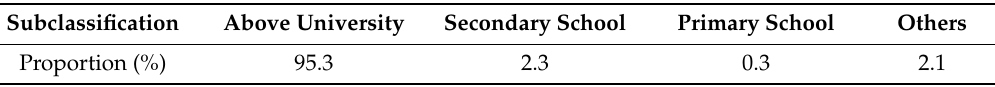
Table 7. Sub-classifications and respective proportions of education-oriented